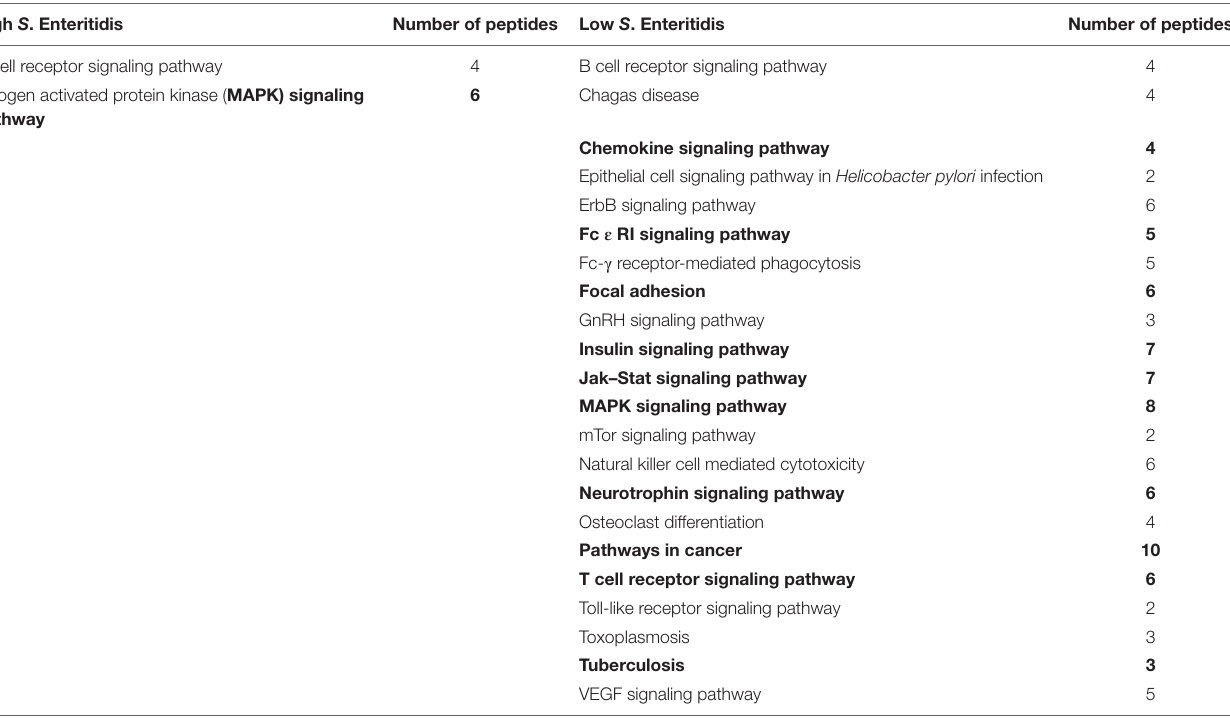
TaBle 2 | Kyoto Encyclopedia of Genes and Genomes (KEGG) pathways identified with the peptide array at the early stage infections in chickens with high and low levels of Salmonella Enteritidis colonization. high S . enteritidis